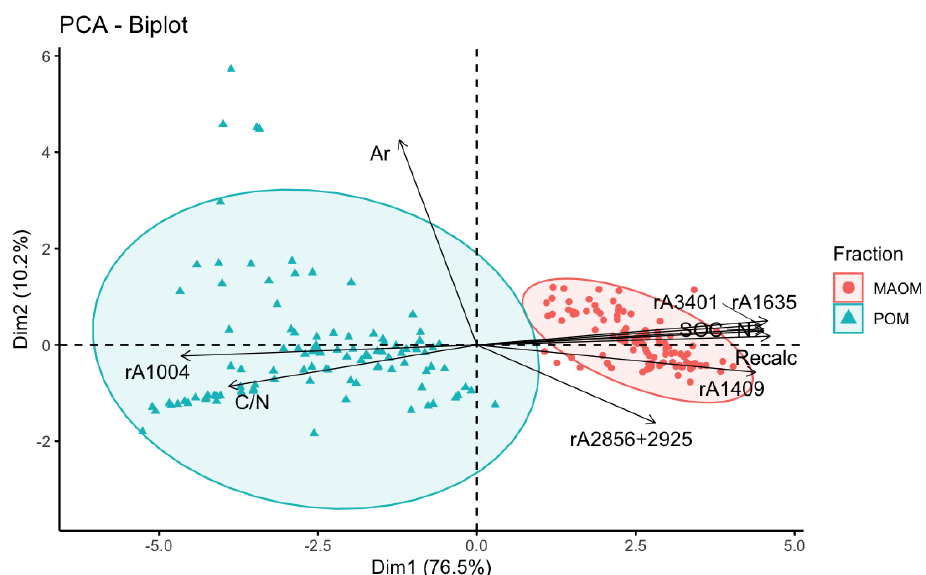
Figure 5. Principal component analysis (PCA) biplot of relative absorbances, C/N ratio, C and N concentrations, recalcitrance (Recalc), and aromaticity (Ar) of MAOM and POM fractions.